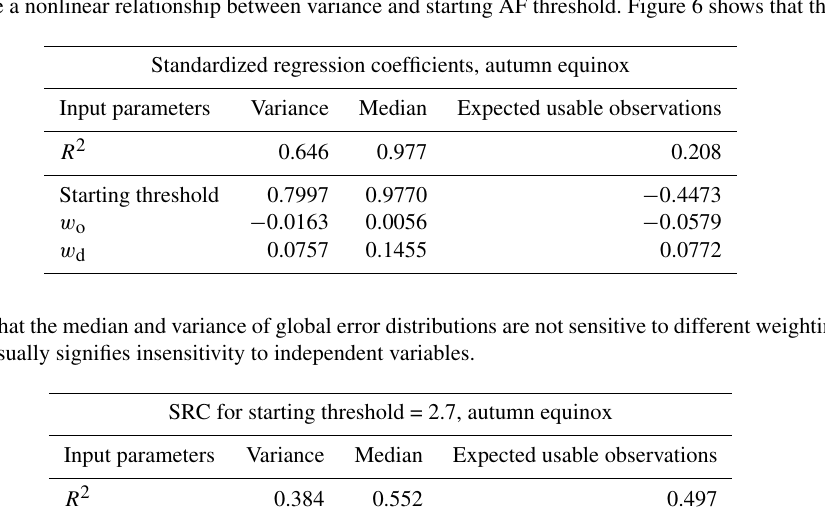
Table 3. The SRCs show that the median of global error distributions is sensitive to starting AF thresholds. The low R 2 value for variance indicates that there may be a nonlinear relationship between variance and starting AF threshold. Figure 6 shows that this is the case.